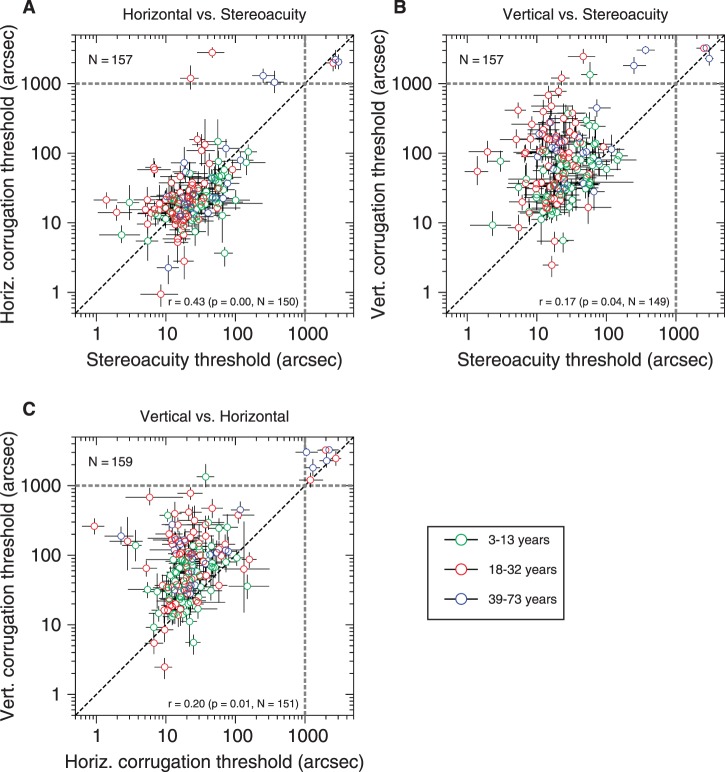
Disparity amplitude thresholds for detection of (A) horizontal and (B) vertical corrugations detection plotted against stereoacuity thresholds; (C) thresholds for vertical versus horizontal corrugations. Diagonal dashed line marks identity; gray dashed lines mark 1000 arcsec. Bottom right of each panel: Pearson correlation coefficient on the log-thresholds for thresholds less than 1000 arcsec. Error bars represent the 68% confidence interval.